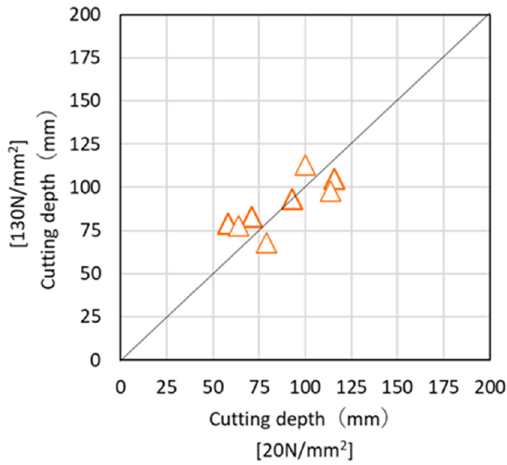
Figure 5. Correlation between cutting depth and concrete strength (laser 6 kW).